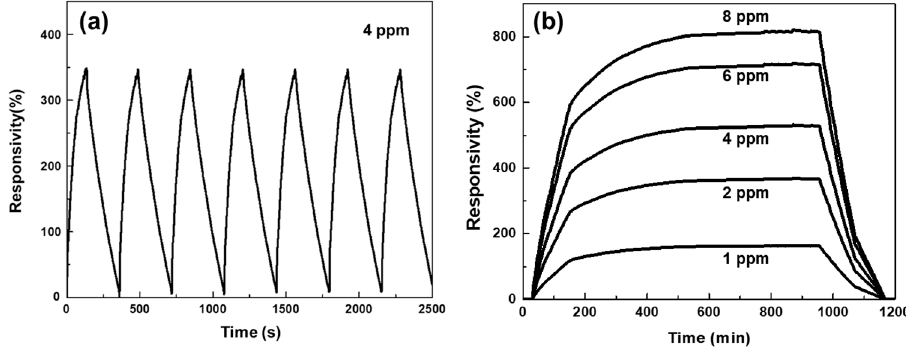
Figure 7. ( a ) Repetitive and ( b ) saturate responses of the N-doped NiO-NS-based NO 2 sensors.